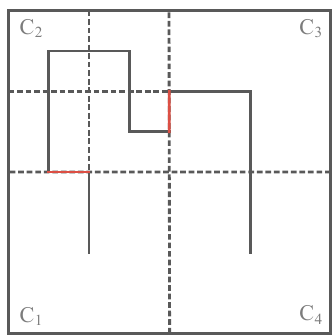
Figure 7. An example of adjustable power control.